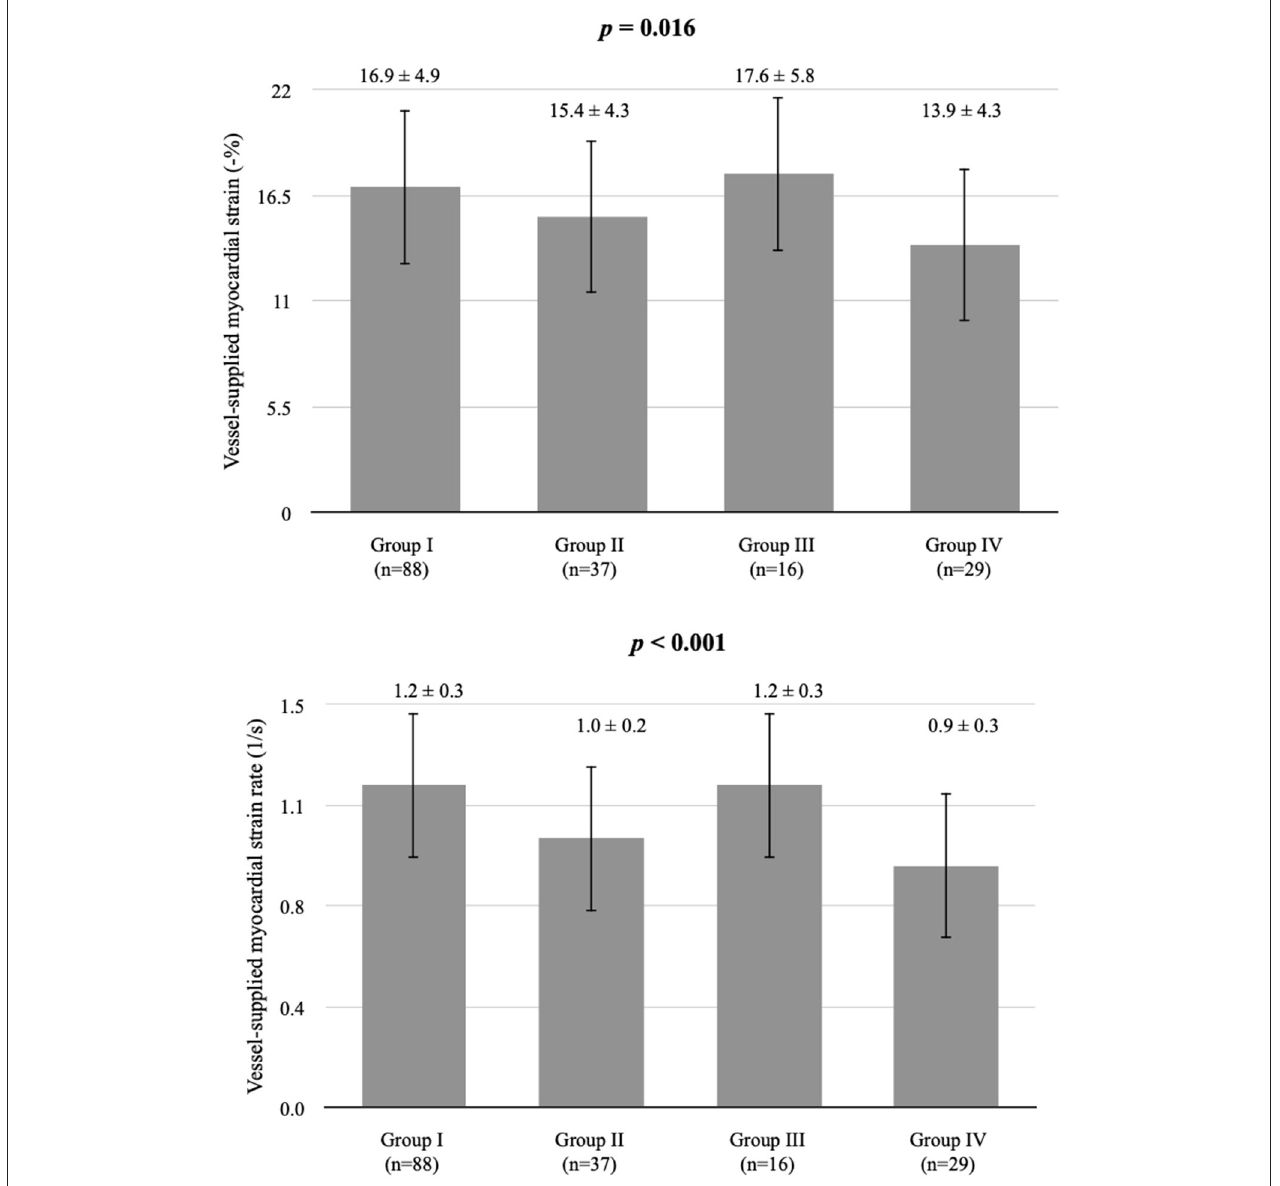
FIGURE 3 | Comparison of longitudinal strain and SR in vessel-supplied myocardium according to coronary artery stenosis severity. *Group I, mild, stenosis ≤ 25%; group II, moderate, stenosis 26–49%; group III, severe, stenosis 50–74%, and group IV, very severe, stenosis ≥ 75% following criteria modified from Arbab-Zadeh and Fuster (22, 23). Vessel-supplied myocardial strain is presented as a percentage. Vessel-supplied myocardial SR is in the unit of